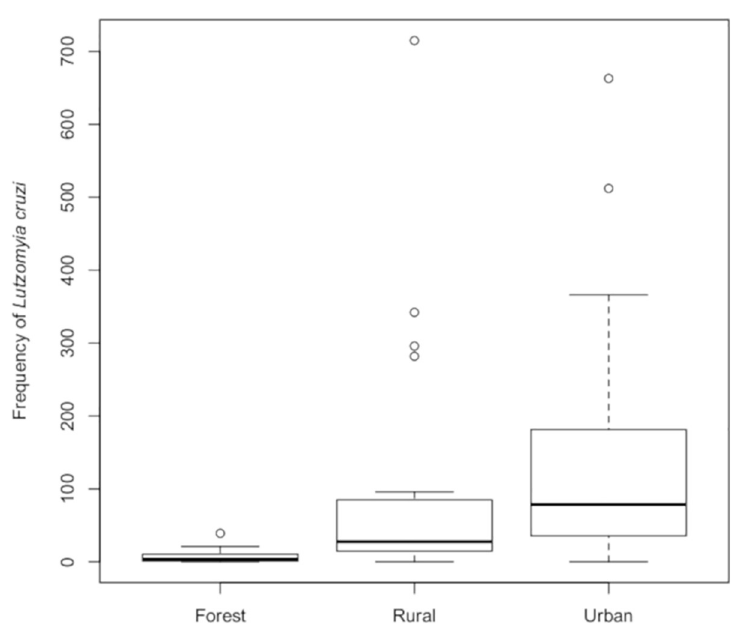
Fig 3. Absolute frequency of Lutzomyia cruzi in three areas (forested, rural, urban). Corumba´, Mato Grosso do Sul, Brazil. May 2015 to April 2017.